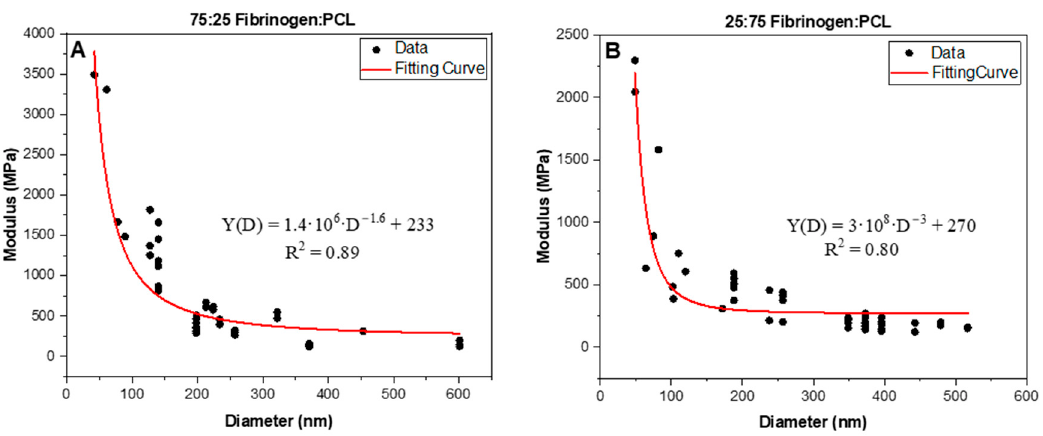
Figure 3. Young’s modulus as a function of fiber diameter of electrospun fibrinogen:PCL nanofibers with two different ratios ( A ) 75:25 ( N = 43), ( B ) 25:75 ( N = 44), N is the number of data points. The Young’s modulus increases drastically as the diameter decreases below 150 nm. However, the Young’s modulus only weakly depends on fiber diameter, D , for D > 150 nm. The graphs show the fit of a power law Y ( D ) = a · D − b + c , where Y is the modulus, D is the fiber diameter and a , b , c are fitting parameters.